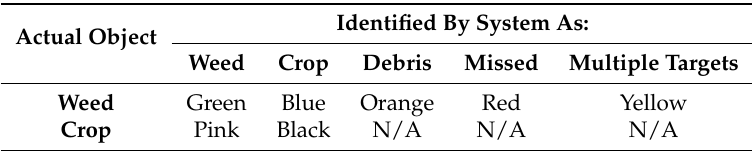
Table 3. Key for labelling of system